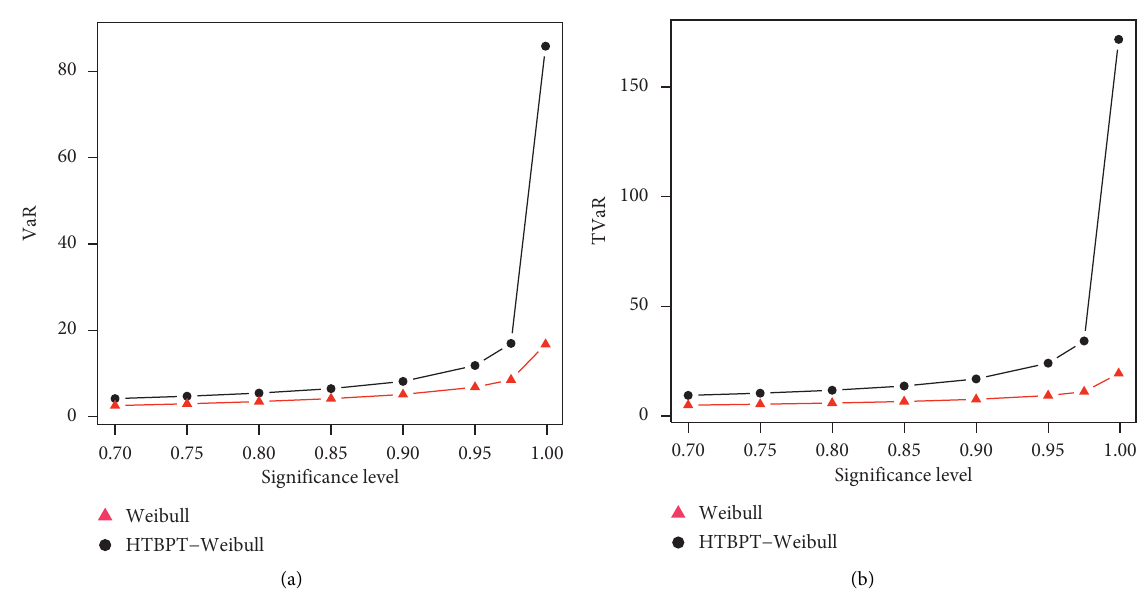
Figure 11: Graphical sketching of the numerical results provided in Table 4.